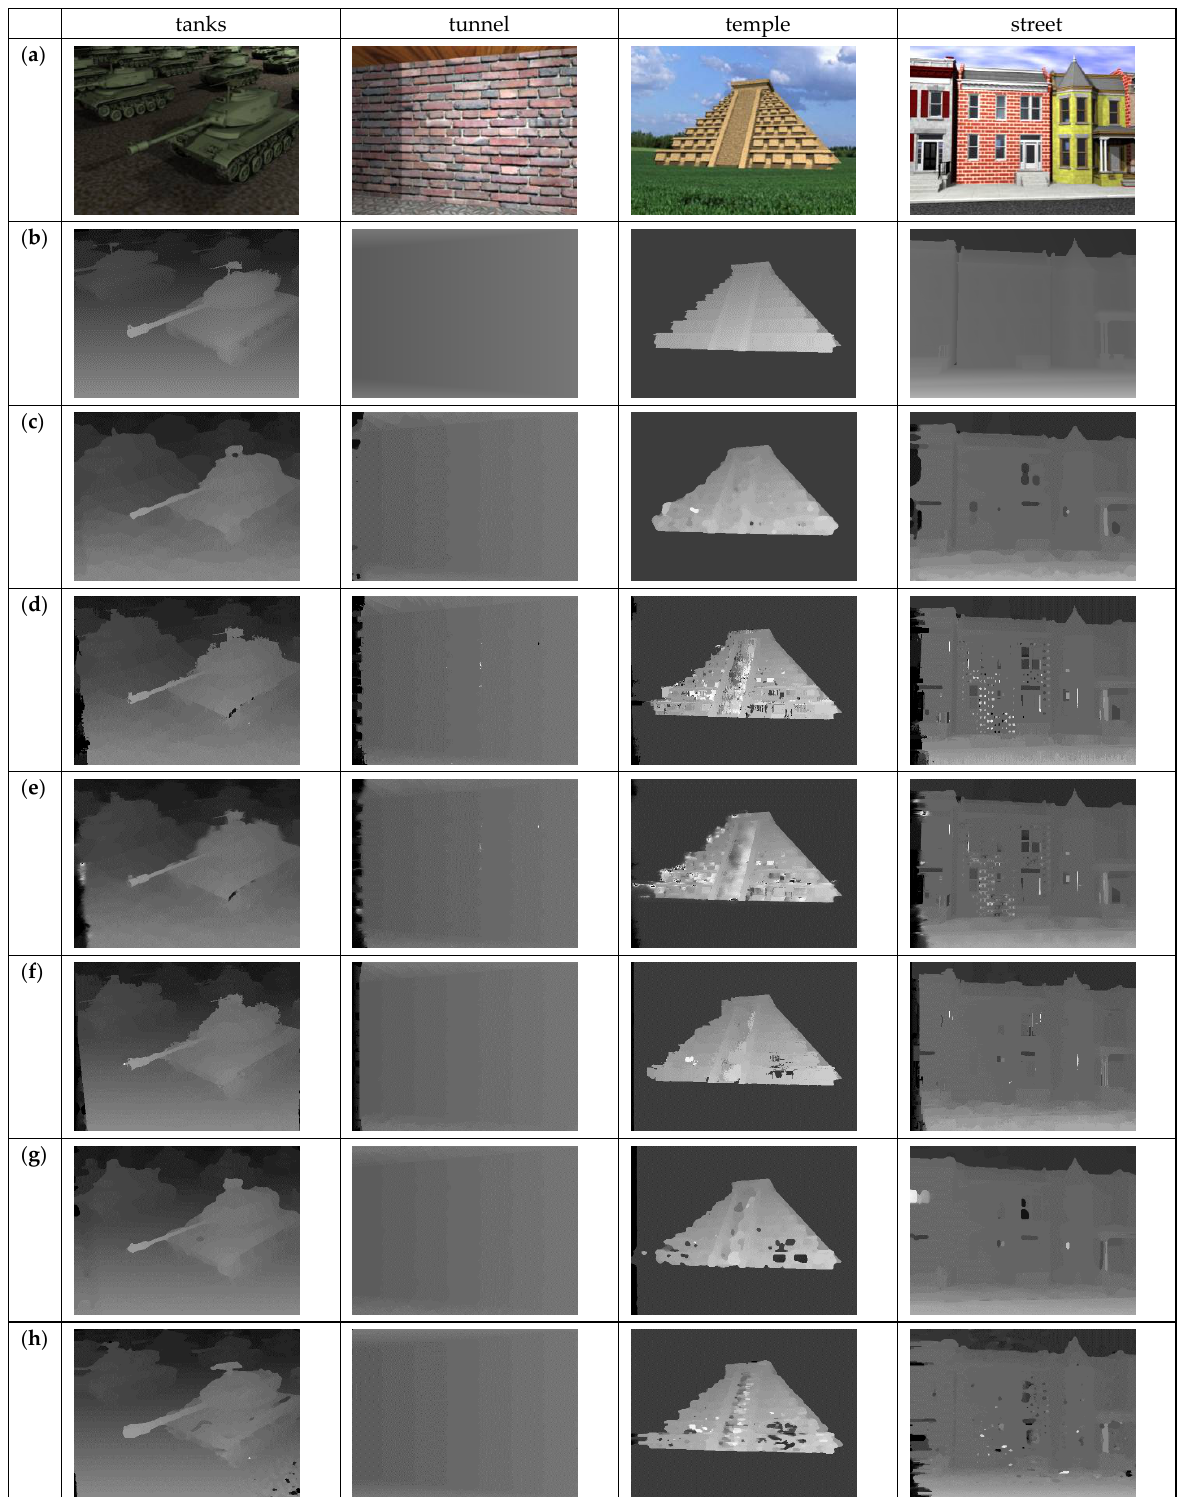
Figure 12. Refined results for 65th frame [9]: ( a ) original image; ( b ) ground truth; ( c ) our proposed method; ( d ) method of Zhang et al. [5]; ( e ) method of Lin et al. [3]; ( f ) method of Jung et al. [12]; ( g ) method of Zhan et al. [14]; and ( h ) method of Yang et al. [7].